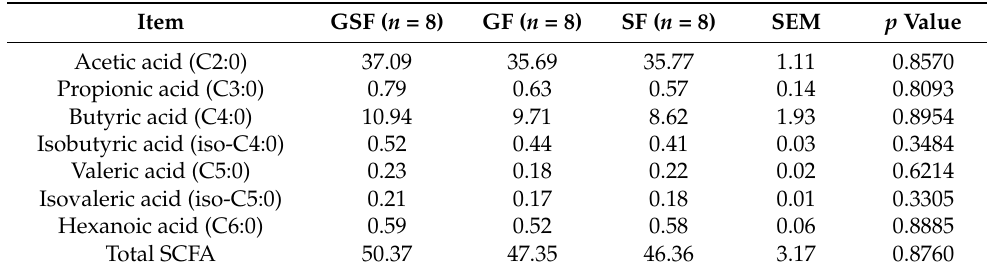
Table 2. Effect of feeding system on adipose tissue fatty acid content ( µ g/g) in the LD muscle of Tan